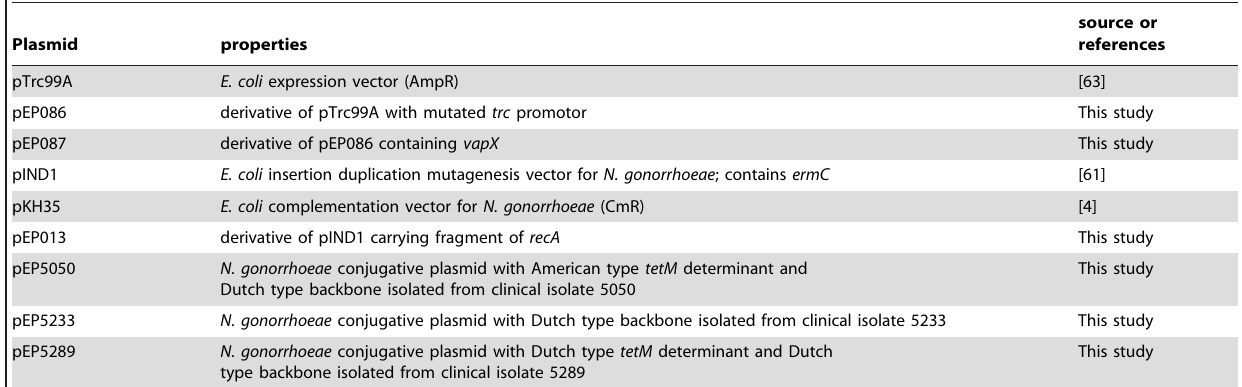
Table 4. Plasmids used in this